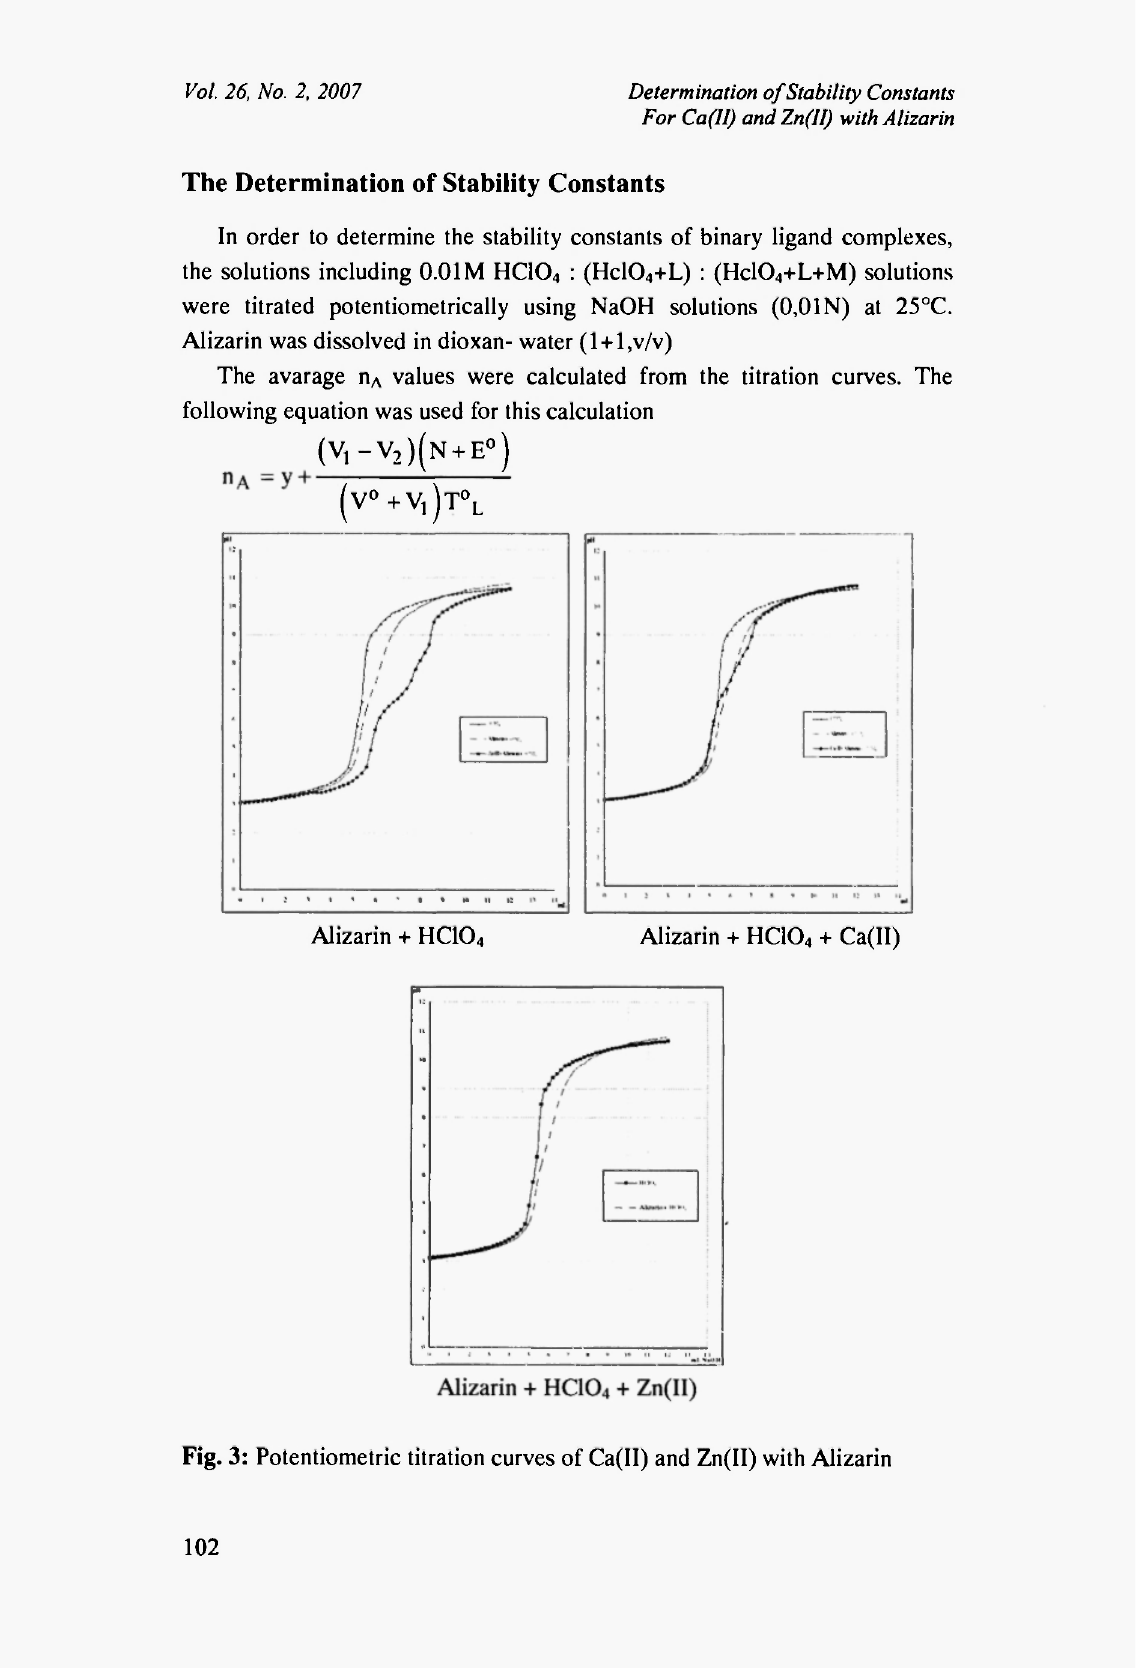
Fig. 3: Potentiometrie titration curves of Ca (II) and Zn (II) with Alizarin